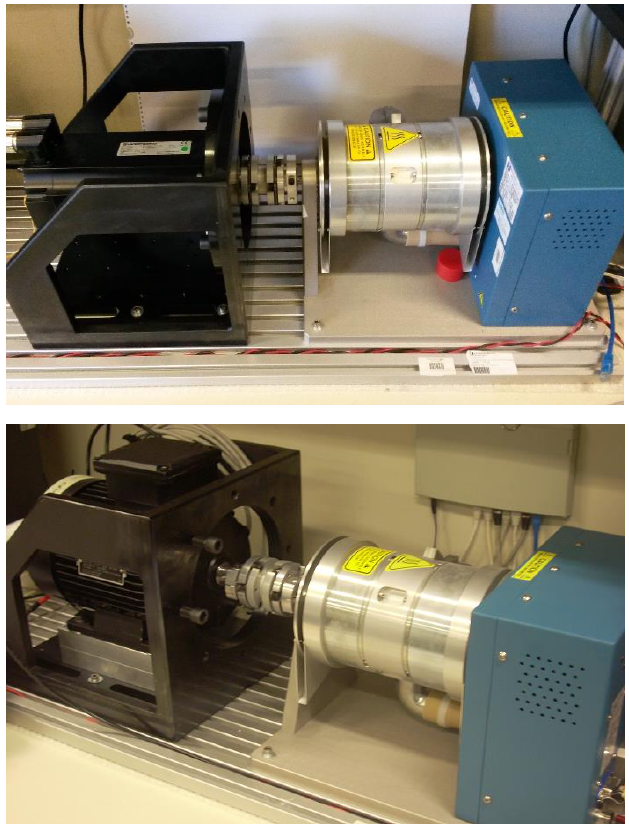
Figure 7. Test-bench used for the experimental investigations: motor #1 ( top ) and motor #2 ( bottom ) connected to the hysteresis brake.